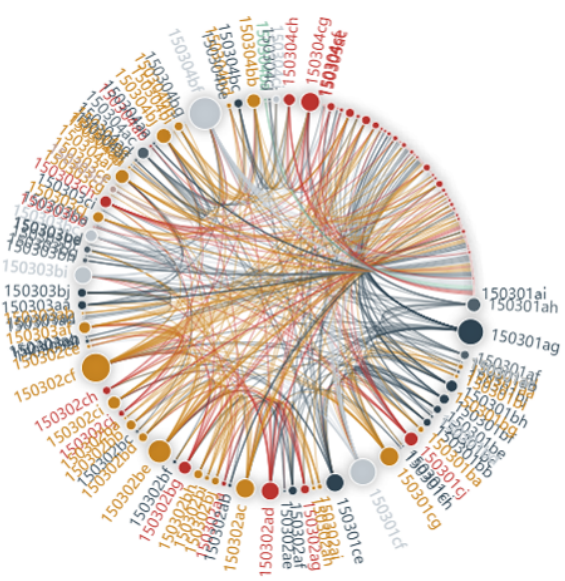
Figure 2. Chord diagram for associations among